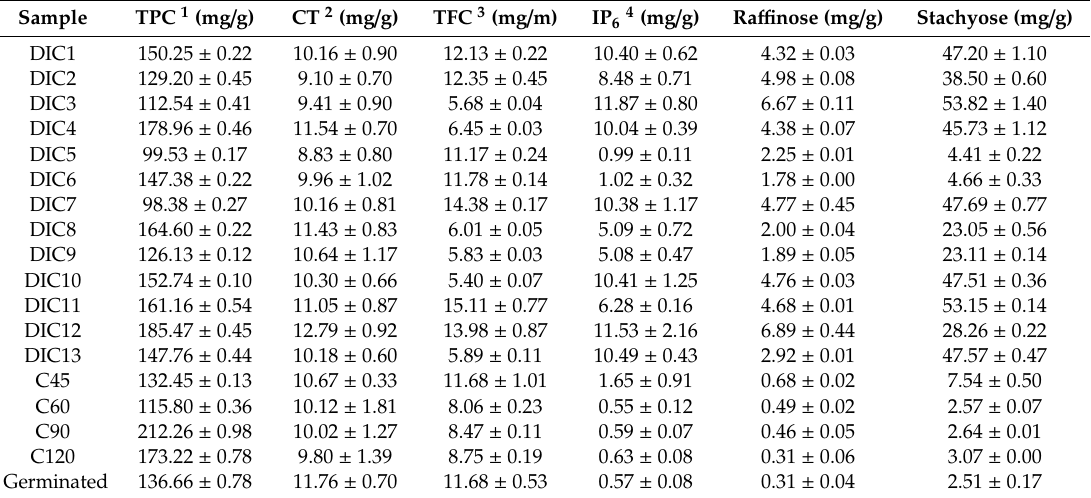
Table 2. Total phenolics content, condensed tannins content, total flavonoids content, phytic acid content, ra ffi nose and Stachyose content of DIC, cooked, germinated and raw vetches. Sample